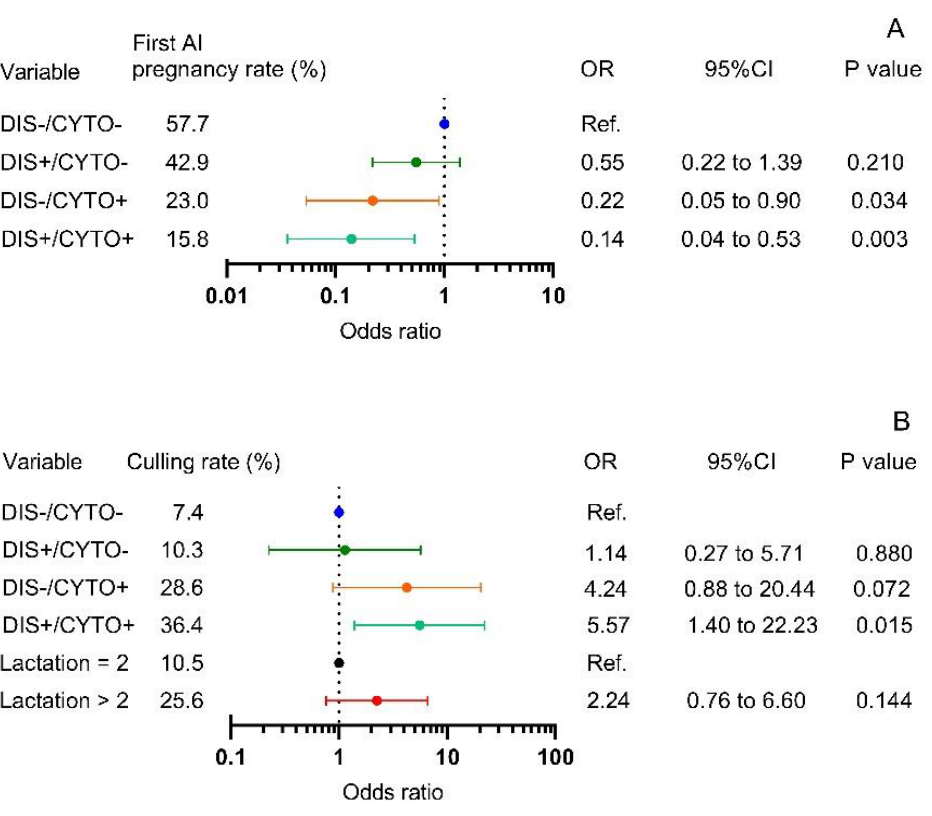
Figure 1. Odds ratios (OR) and 95% confidence intervals (CI) from logistic regression models for first artificial insemination (AI) pregnancy rate ( n = 112) ( A ) and culling rate ( n = 119) ( B ) for multiparous Holstein cows stratified by disease (DIS) and cytological endometritis (CYTO) statuses (DIS − /CYTO − = disease-negative/CYTO-negative; DIS+/CYTO − = disease-positive/CYTO-negative; DIS − /CYTO+ = disease-negative/CYTO-positive; DIS+/CYTO+ = disease-positive/CYTO-positive). OR for culling was adjusted for lactation number (=2 and >2). OR < 1 indicates a reduced relative risk; OR >1 indicates an increased relative risk.